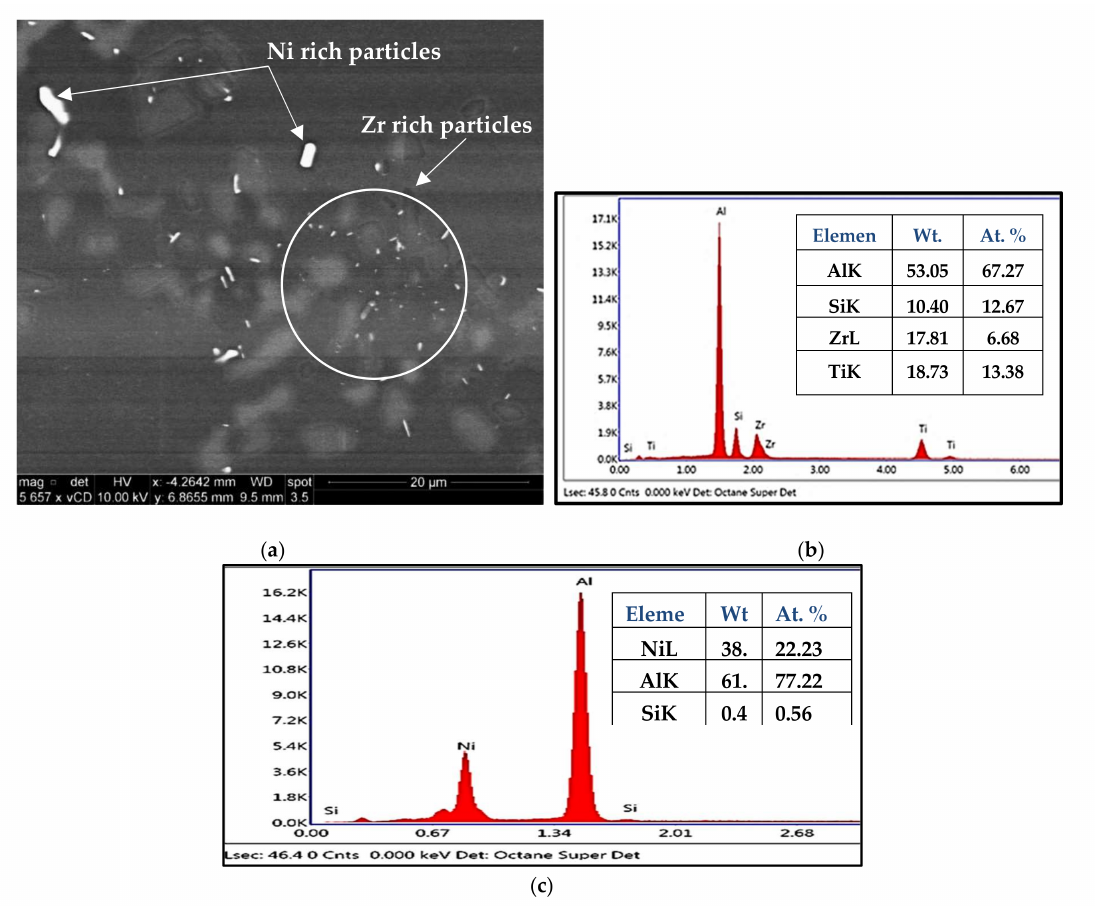
Figure 6. Backscattered electron images showing ( a ) bright coarse and fine dispersoids in the T6-treated M2S alloy after stabilization at 250 ◦ C for 1 h and testing at the same temperature, ( b ) EDS spectrum corresponding to the bright particles in the circled area in ( a ), ( c ) EDS spectrum corresponding to Ni-rich particles in ( a